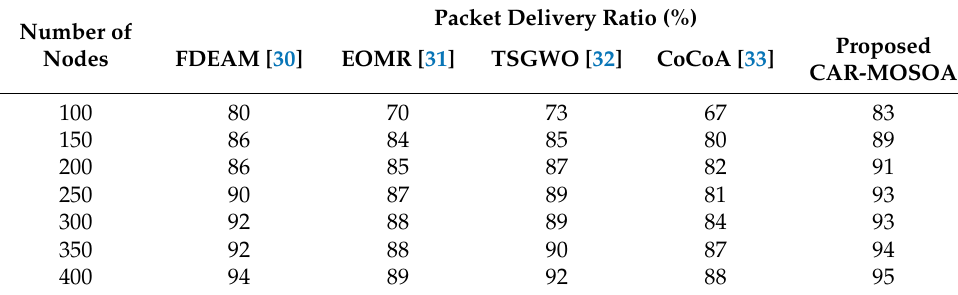
Table 4. Comparative analysis of packet delivery ratio.